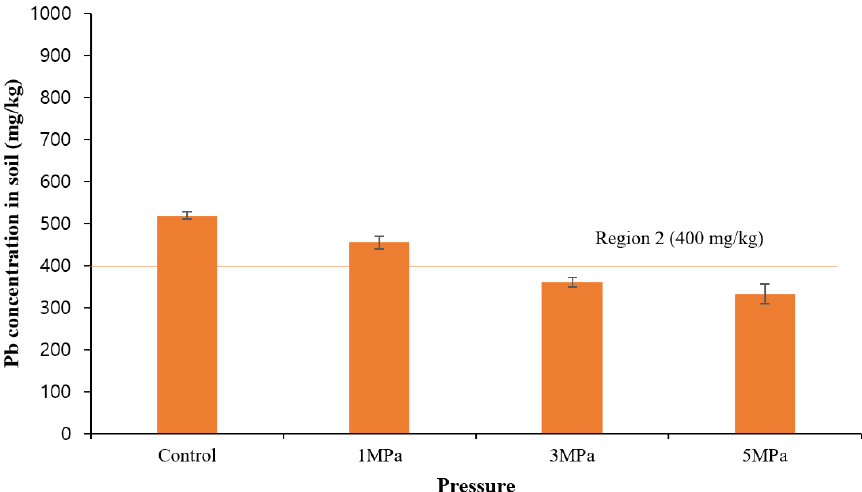
Figure 4. Pb concentrations remaining in the soil after high-pressure washing at 1, 3 and 5 MPa.